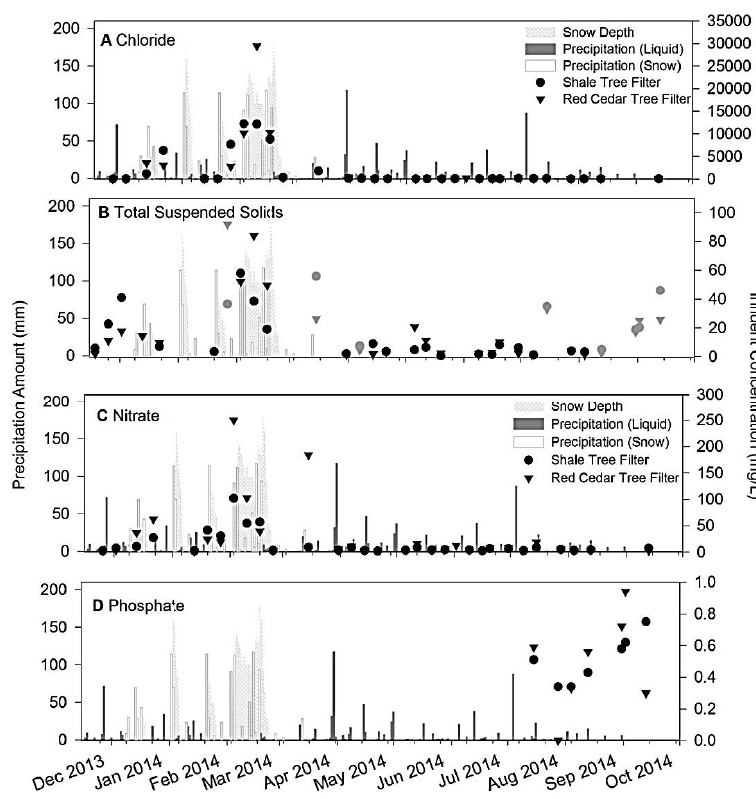
Figure 3. Relationship between snow depth, daily snow fall and influent concentrations of ( A ) Chloride and ( B ) total suspended solids; ( C ) Nitrate; and ( D ) Phosphate measured in both tree filters. In ( B ) the grey colored circles and triangles indicate the dates when TSS samples were taken during storm or intense snowmelt events.